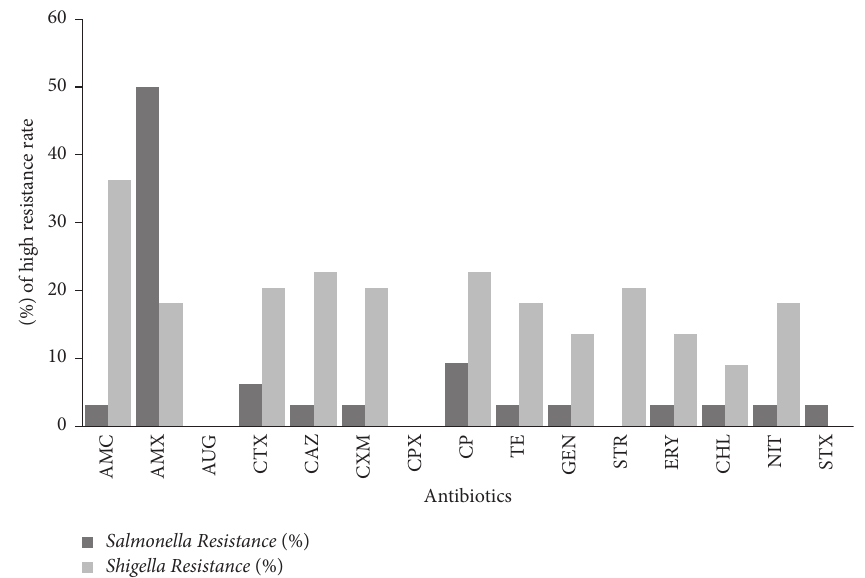
Figure 3: Percentage of high resistance rate of antibiotics isolates in Salmonella spp. and Shigella spp. Table 4: Multidrug resistance indexes (MARIs) of the isolates. Isolates